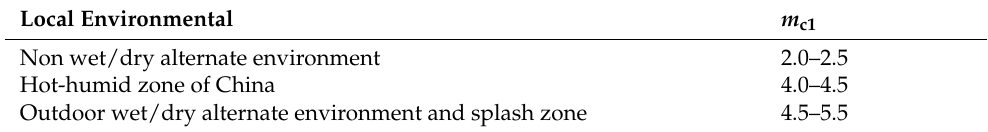
Table 1. Local environmental coefficient. Local